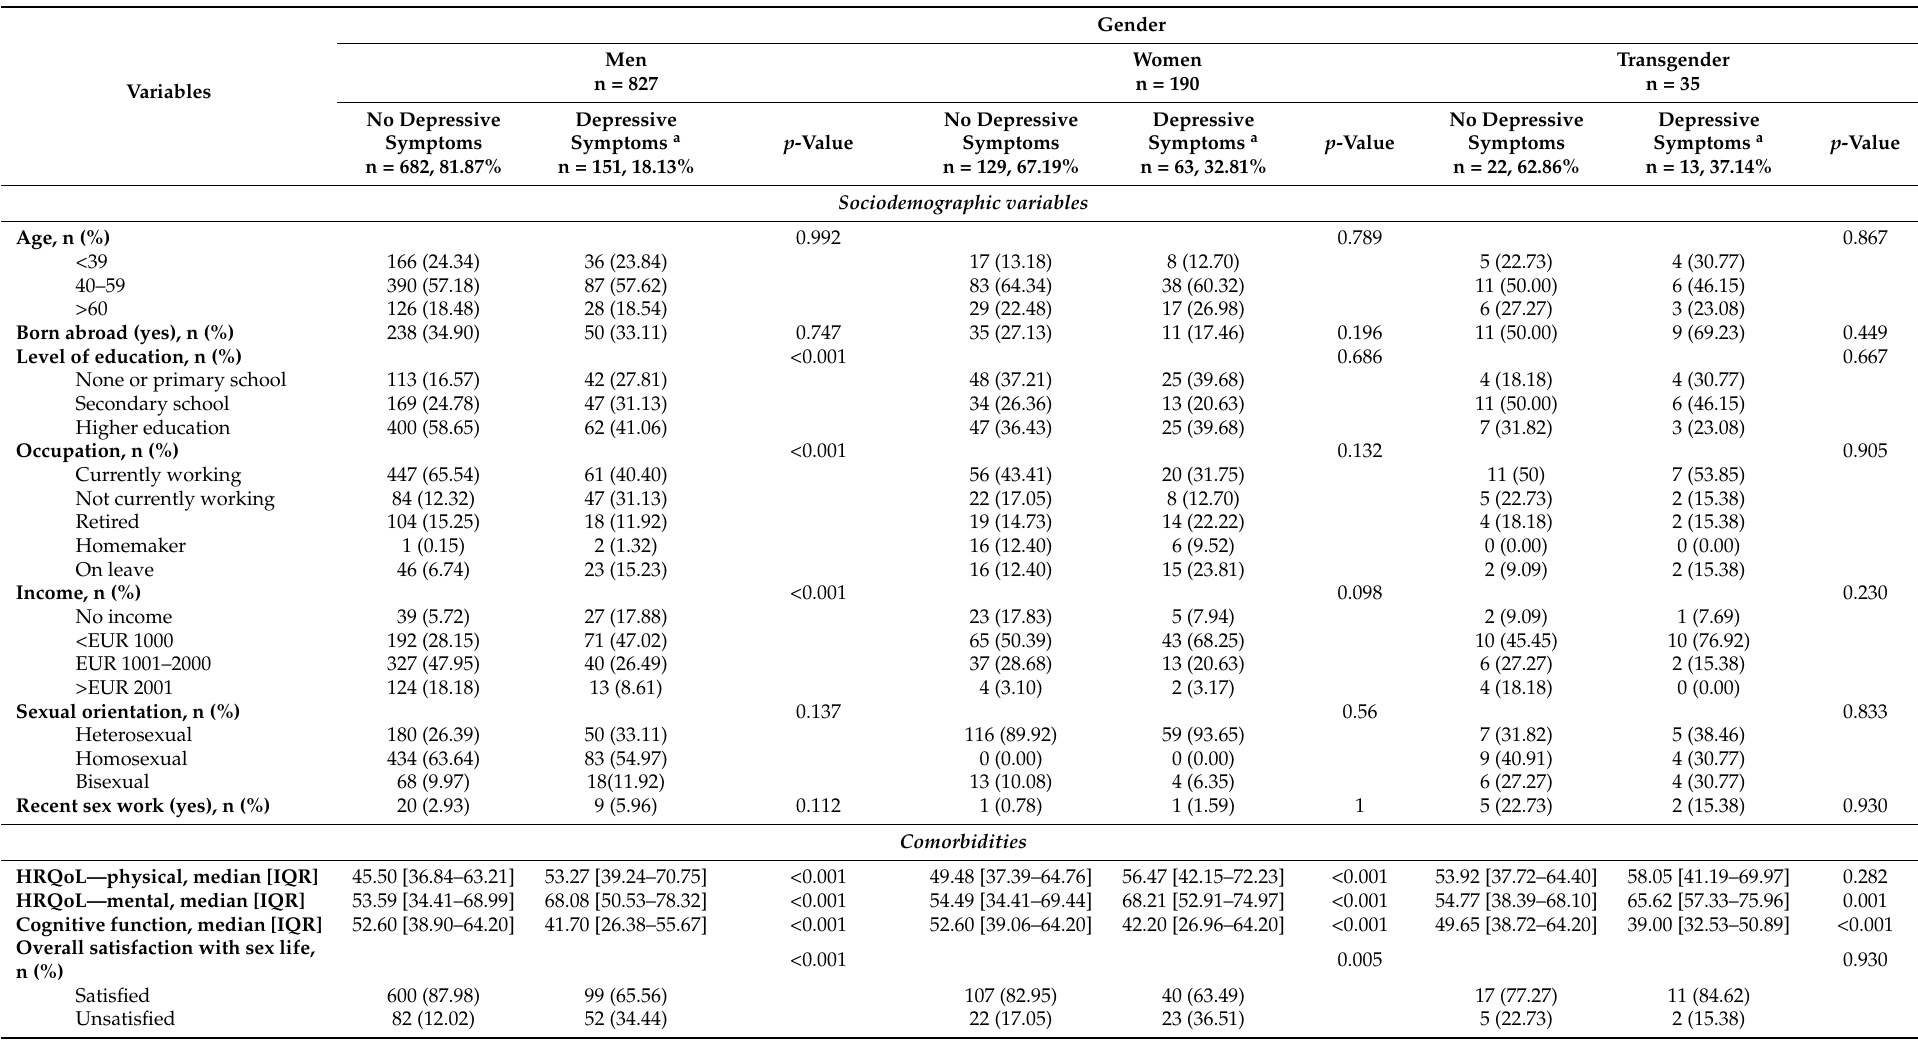
Table 2. Characteristics of the total sample by gender and prevalence of depressive